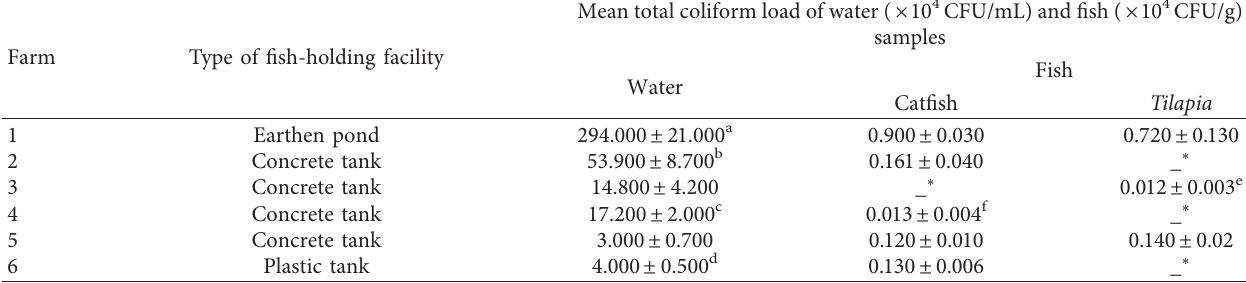
Table 1: Total coliform loads of fish and water samples from various fish